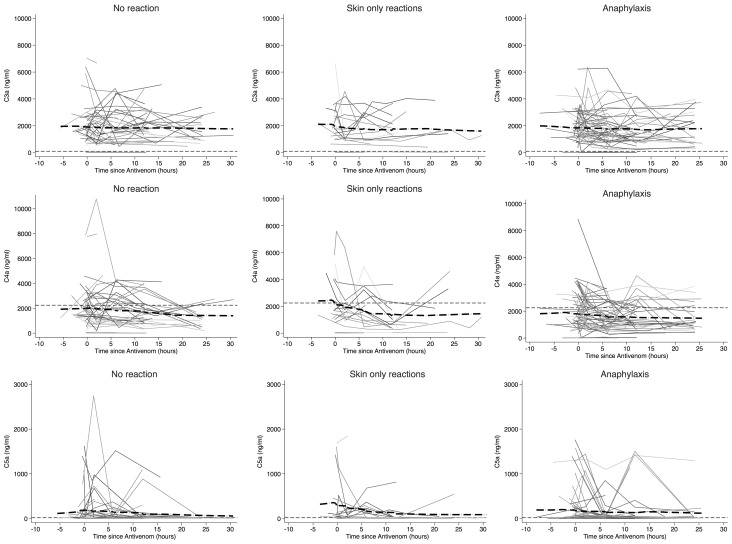
Changes in anaphylatoxin (C3a, C4a and C5a) concentrations during treatment with antivenom.Lowess curve (thick dash-dot line). Upper limit (99th centile healthy control values from our laboratory) (thin dashed line). There were no significant differences between pre-antivenom concentrations and peak concentrations during the first four hours post-antivenom for C3a, C4a or C5a (p>0.13 for all comparisons, Wilcoxon Signed Rank Test).